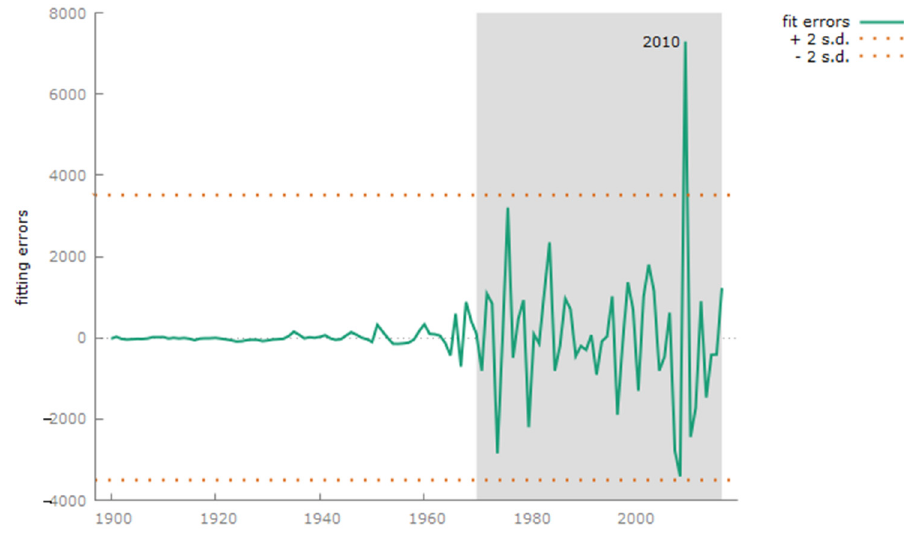
Figure A2. Fitting errors and two standard deviations (s.d.) bands.